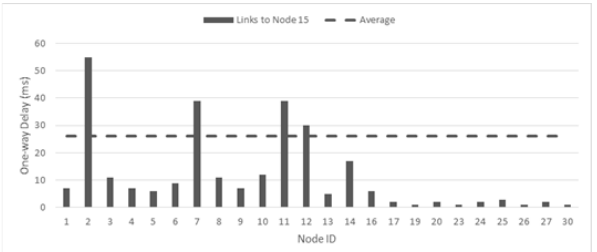
Fig. 19. Link Latencies for Links Connecting Node 15 of